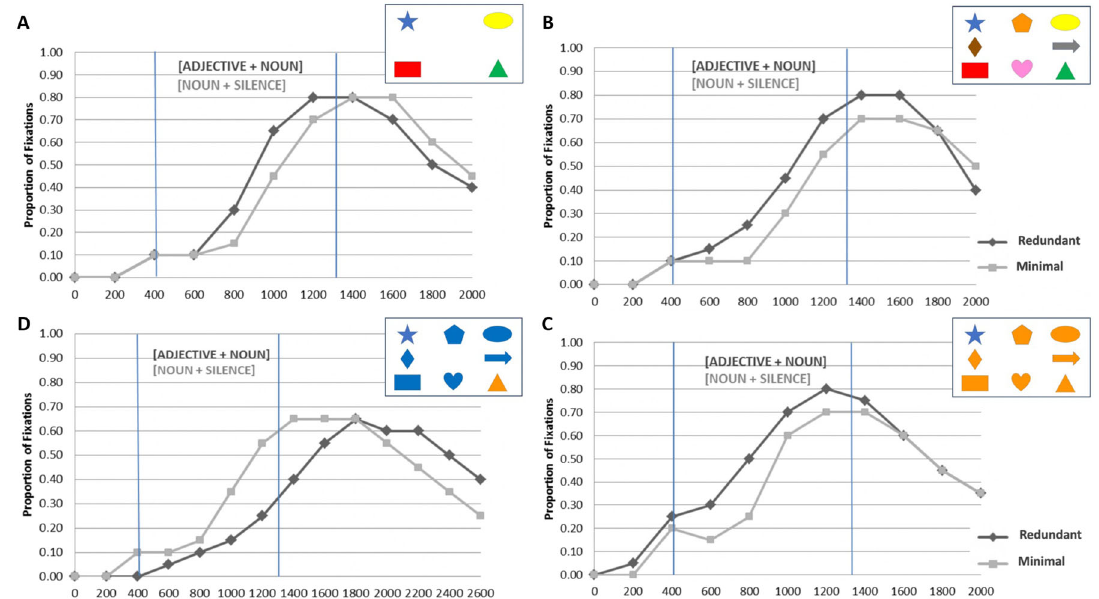
Fig. 5 Proportion of target fi xations across time in the four visual conditions of Experiment 1. A – D Proportions of target fi xations during the processing of redundant instructions ( “ Click on the blue star ” ) and minimal instructions ( “ Click on the star ” ) in conditions ( A ) Polychrome/4, ( B ) Polychrome/8, ( C ) Pop-Out/8, and ( D ) Non-Pop-Out/8. The target in all four displays was the blue star, and color was distinctive of the target in ( A ), ( B ), and ( C ), but was non-distinctive of the target in D . Redundant color adjectives were therefore predicted to have a facilitatory effect in ( A ), ( B ), and ( C ) relative to the minimal instructions, whereas it was predicted that color should delay target identi fi cation in D because it creates a temporary ambiguity. Blue vertical lines mark the critical time window (i.e., [ADJECTIVE + NOUN] in the Redundant condition and [NOUN + SILENCE] in the Minimal